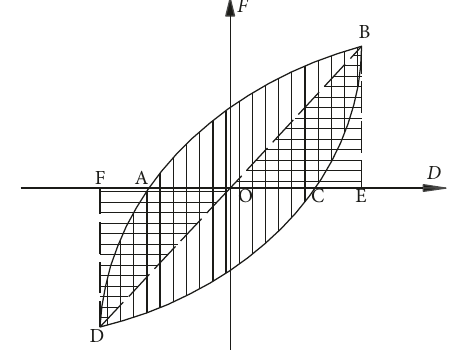
Figure 14: The area graph of load-displacement hysteresis